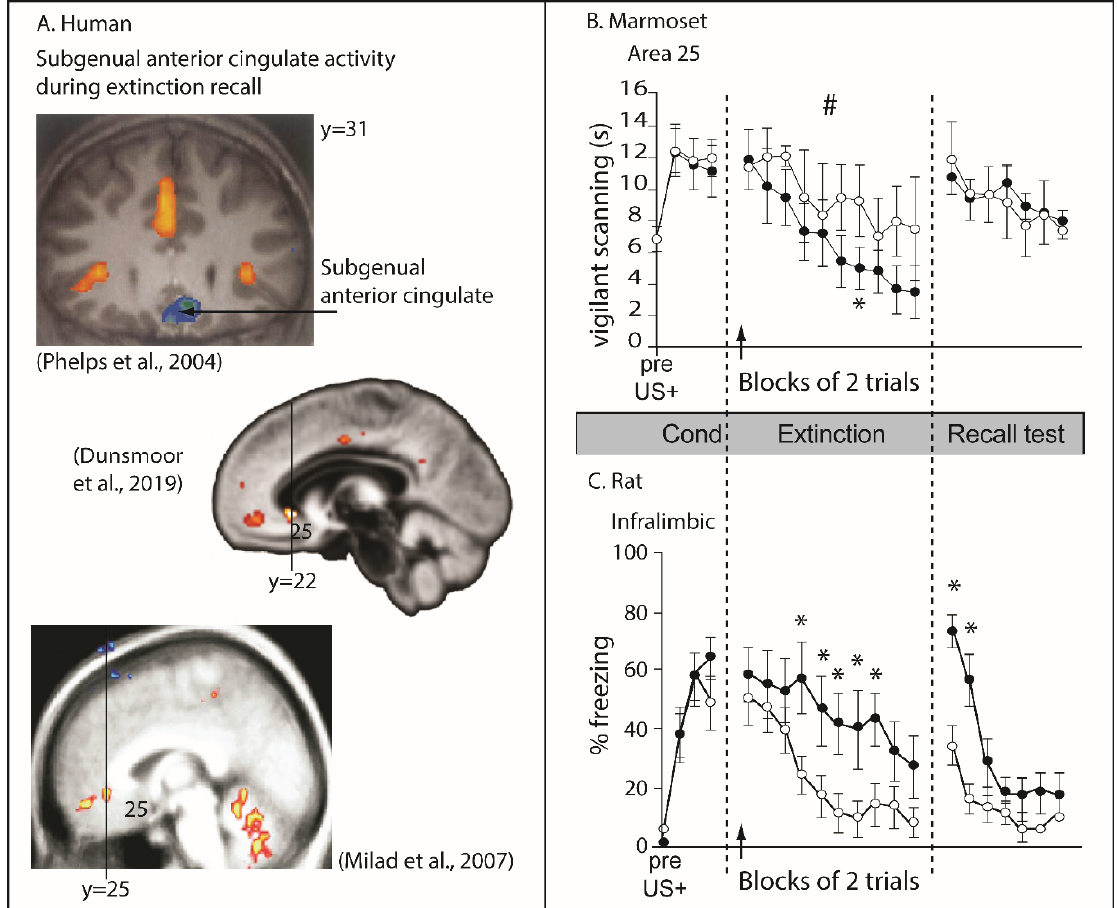
Figure 4. Re-thinking the role of area 25 in threat extinction in humans, marmosets and rats. ( A ) Human neuroimaging of extinction recall has identified regions of the subcallosal zone (scACC) in which the deactivation induced by the conditioned stimulus, CS + is blocked following successful extinction recall [160–162]. However, these regions of activity are generally more rostral than area 25. ( B ) In marmosets, inactivation of area 25 with GABA A and B agonists (muscimol and baclofen; closed circles) hastened the behavioral extinction of an aversive (rubber snake) Pavlovian conditioned association [38]. In contrast ( C ) IL inactivation in rats (muscimol; closed circles) impeded the behavioral extinction and extinction recall of conditioned footshock. Redrawn from Sierra-Mercado et al., [157]. *, p < 0.05; #, p < 0.05, manipulation × CS interaction; error bars indicate SEM. Arrow indicates point of inactivation.